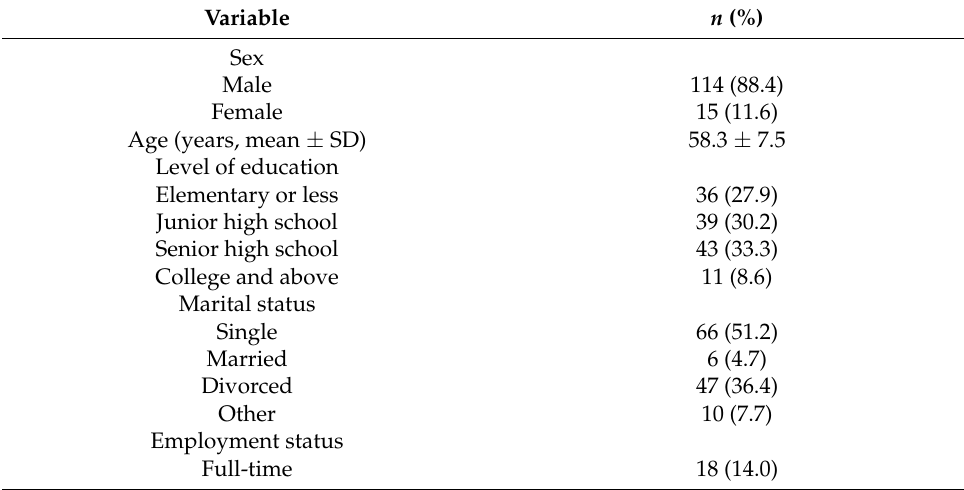
Table 1. Demographic characteristics of the participants ( n =